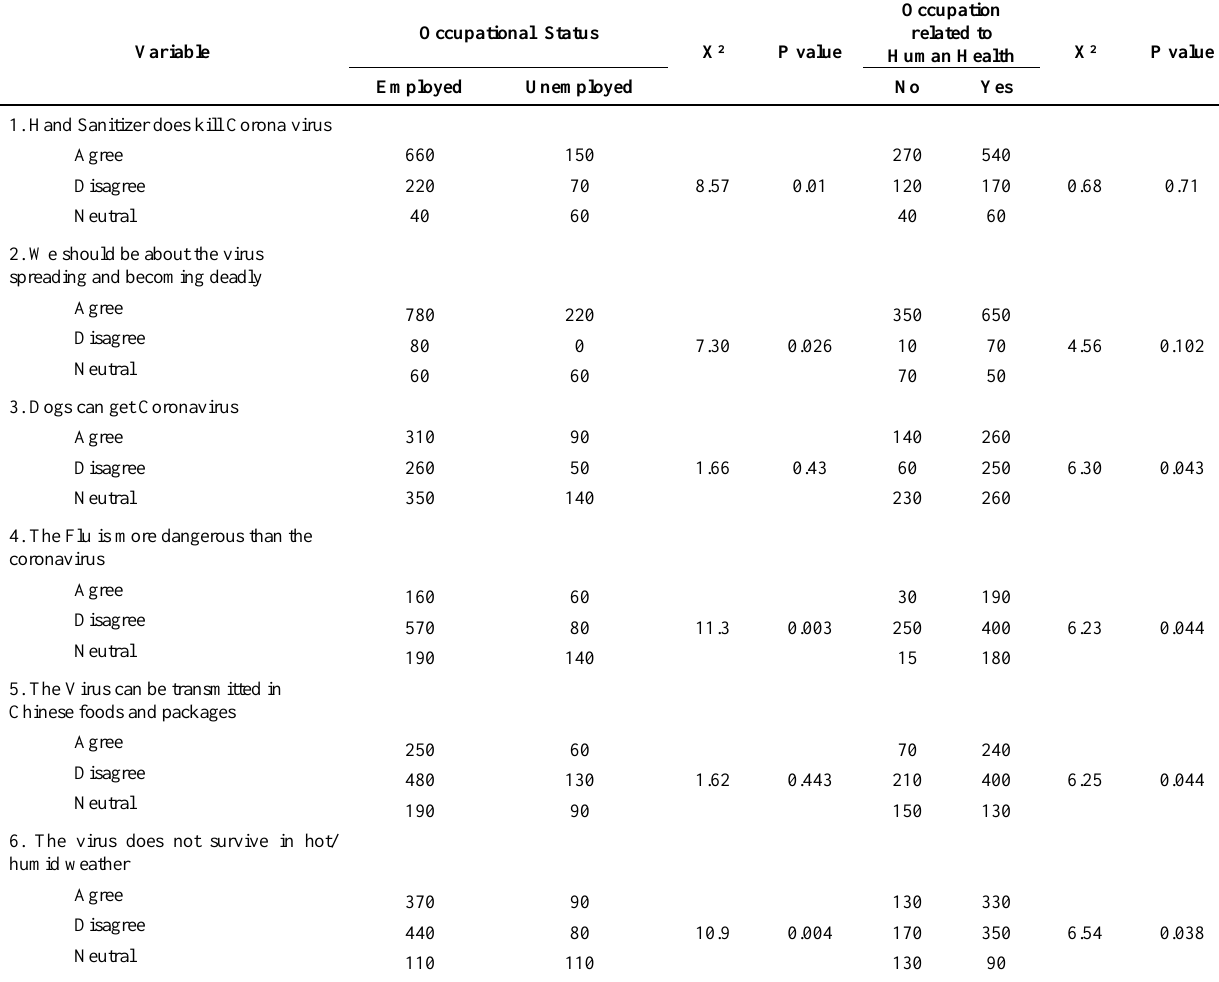
Table 3. Factors that could influence the level of these